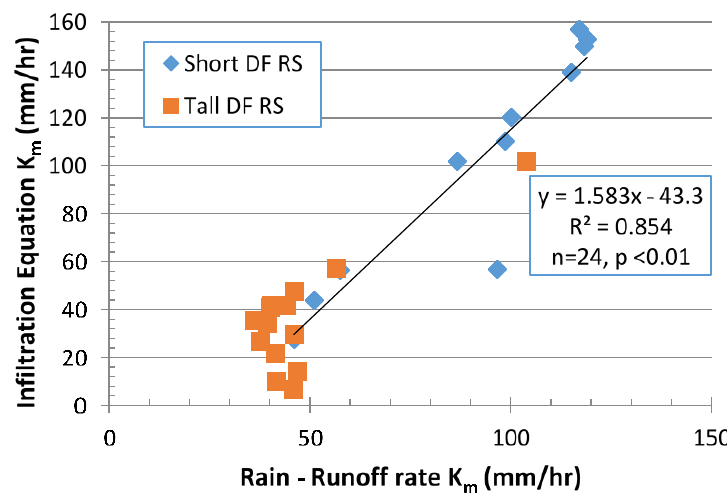
Figure 11. Dependence of Infiltration-equation K m values on Rainfall–Runoff rates for the short and tall DF type RS at Northstar ski area (volcanic soils). Table 13. Summary of plot data for stream power derived soil erodibility for volcanic bare and treated soil RS plots using the tall and short DF type RSs at Northstar ski